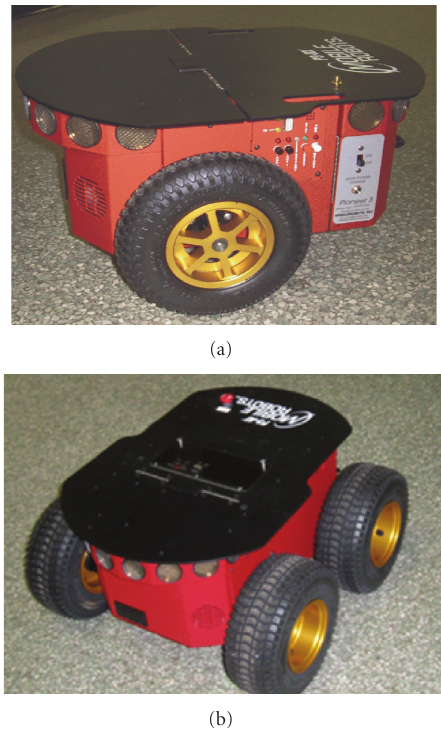
Figure 1: Pioneer 3-DX and 3-AT mobile